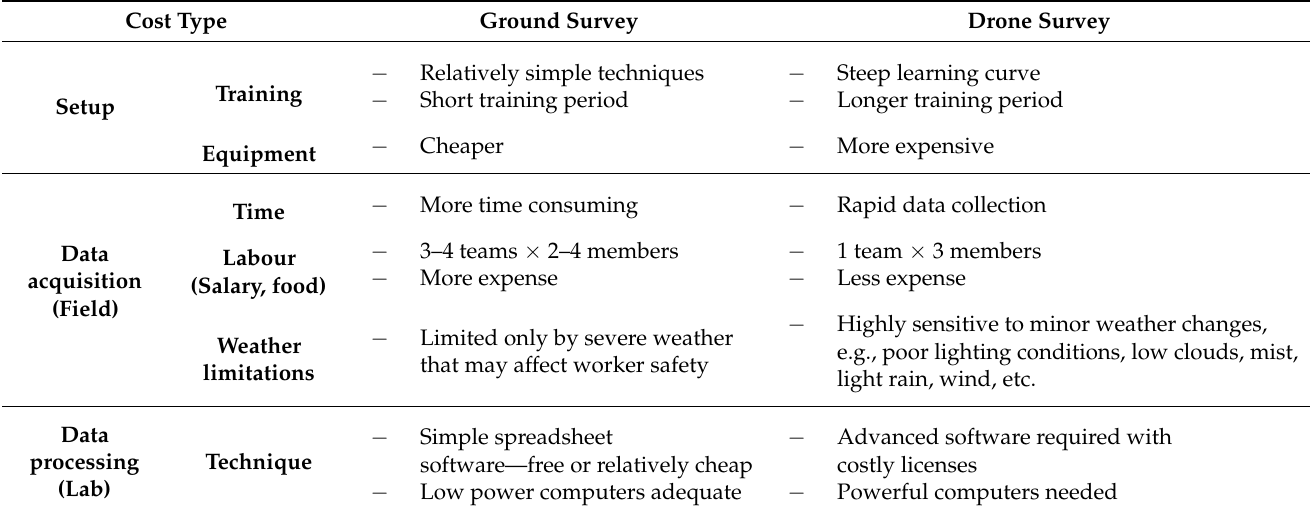
Table 2. Comparison between ground and drone survey methods.